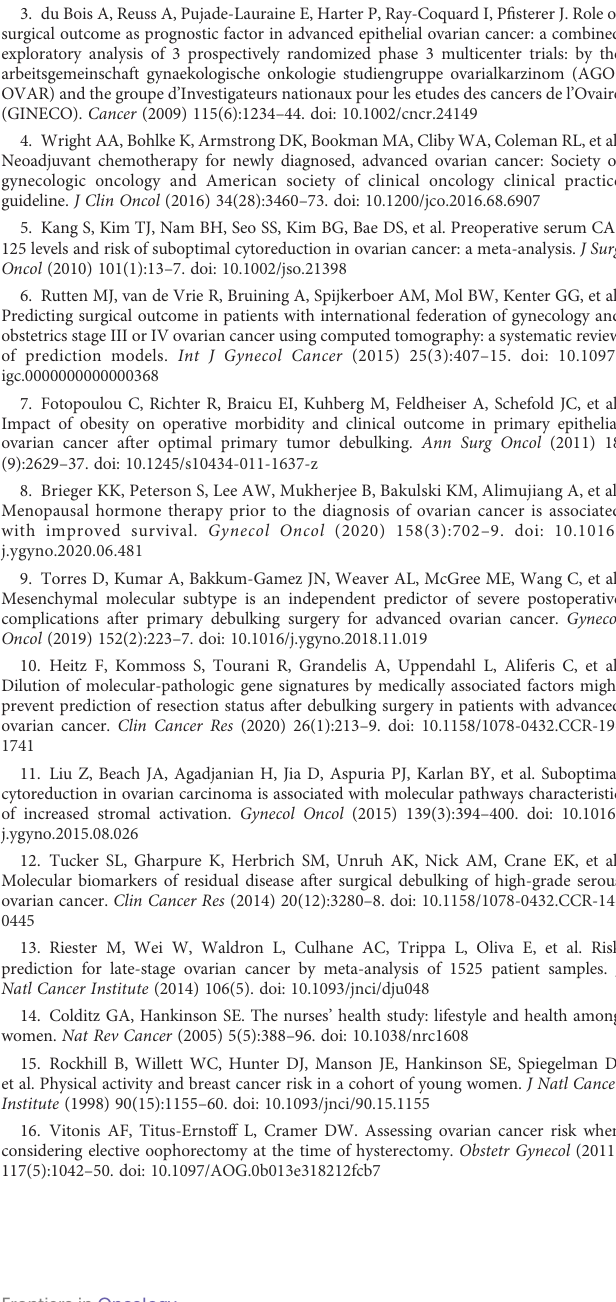
prediction model of optimal debulking status (i.e. aspirin, pack-years of smoking, and menopausal status), for possible selection in the fi nal model and conducted fi ve 5-fold cross-validations. The bar chart (A) presents the average posterior mean across the 25 models that were run in total; grey bars denote predictors with average posterior probabilities <20% and yellow bars denote predictors with average posterior probability ≥ 20%. (B) presents the fi ve average AUCs from the fi ve 5-fold cross-validations and in the legend overall AUC, which is the average of the average AUCs from the 5-fold CV, is presented. Type 2 tumors include high-grade serous or poorly differentiated, Transitional/ Brenner, Carcinosarcoma, high grade mixed